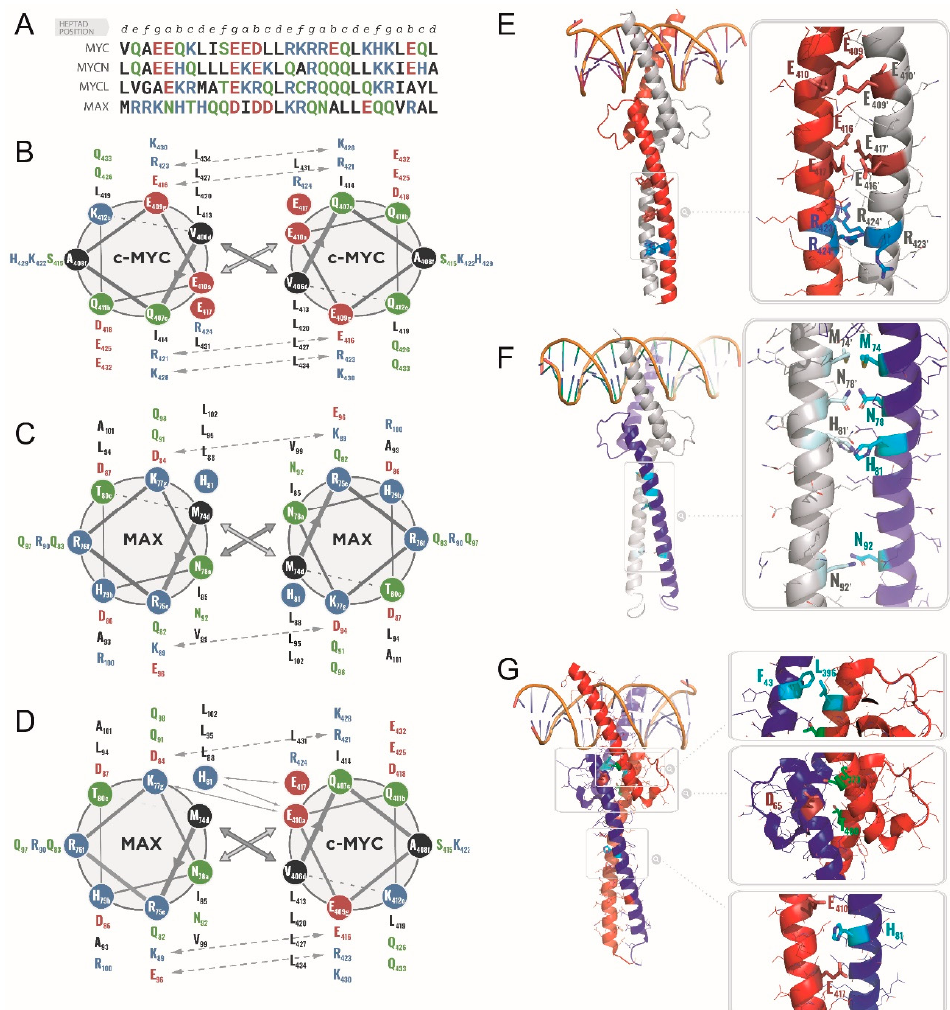
Figure 4. ( A ). Sequence alignment of the LZ of MYC, MYCL, MYCN, and MAX with heptad-repeat numbering. ( B – D ). Helical-wheel representation for the interfacial interactions in the LZ domains from MYC and MAX putative dimeric complexes: The MAX / MAX homodimer is shown in panel ( B ), the putative MYC / MYC homodimer in panel ( C ) and the MYC / MAX heterodimer in panel ( D ). The favorable and unfavorable inter-molecular contacts are displayed as arrows. The amino acids are colored blue for positively charge residues, red for negatively charged residues, green for polar residues and black for the remainder apolar residues. Adapted from Lavigne et al. 1995 [40]. ( E , F ) Molecular models of the tridimensional structure of a putative DNA-bound MYC homodimer ( E ), of the crystal structure of the MAX homodimer (PDB 1AN2, F ) and of the MYC / MAX heterodimer (PDB 1NKP, G ). ( E ). Homology model of a putative MYC / MYC homodimer (the sequence of MYC was superimposed on the MAX structure from 1NKP.pdb) with one monomer shown in red and the other in grey. The inset highlights the highly unfavorable electrostatic repulsions between the clusters of negatively charged interfacial residues Glu409-Glu410, Glu416-Glu417, and Arg423-Arg424 and their respective counterpart on the other monomer are shown with stick representation. Negatively charged residues are shown in red, positively charged residues in blue. F. Crystal structure of the MAX homodimer; the inset evidences the polar residues at interfacial a and d positions, namely Met74, Asn78, His81, Asn92 (shown in cyan stick representation). ( G ). Crystal structure of the MYC / MAX heterodimer with close up views on the MYC-Leu396 / MAX-Phe43 interaction within the HLH (top inset); the Ser373 and Thr400 phosphorylation sites are shown in green (note: Asp65 from MAX, directly facing MYC-Ser373, is shown in red—middle inset); the interfacial, buried interaction between MAX-His81 (cyan) and MYC-Glu410 and Glu417 (in red) is shown (bottom